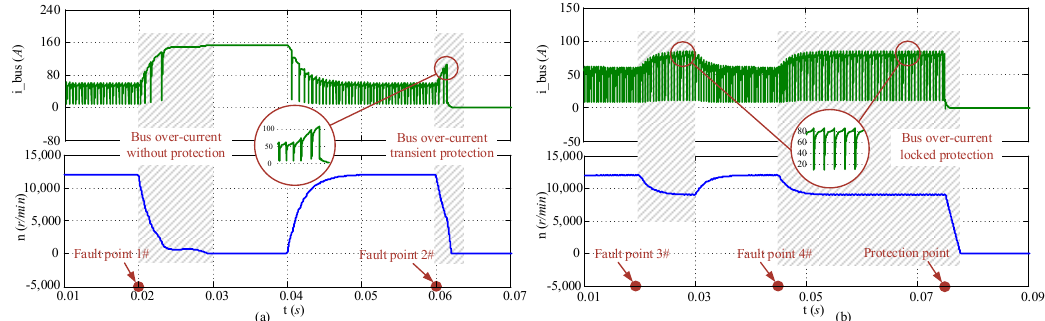
Figure 15. Waveforms of bus-current and motor speed during bus over-current fault protection processes; ( a ) transient protection; ( b ) locked protection.